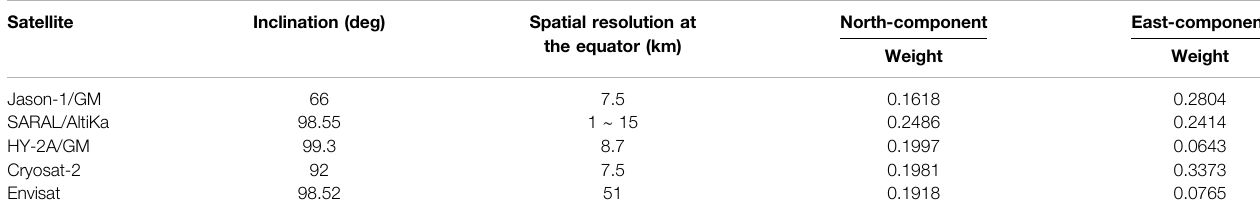
TABLE 8 | Contribution of each satellite in establishing the de fl ections of the vertical.